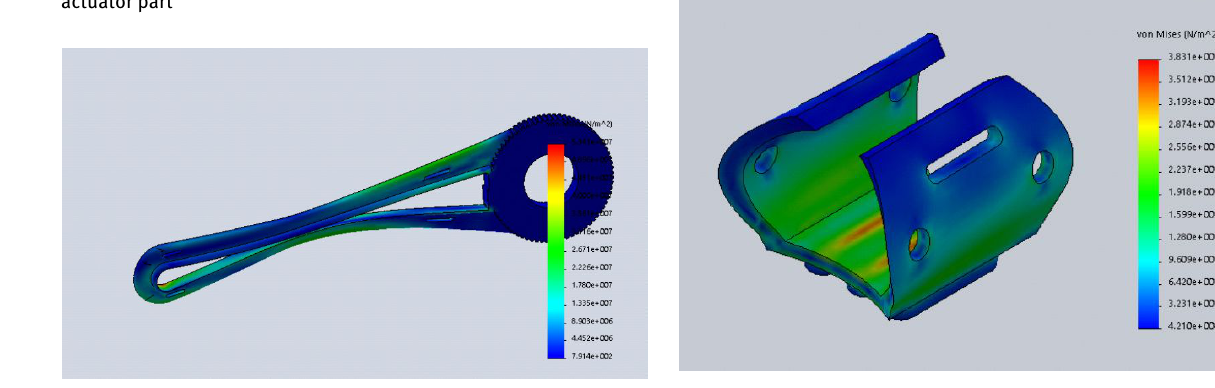
Figure 10: Second design prepared and simulated for the finger